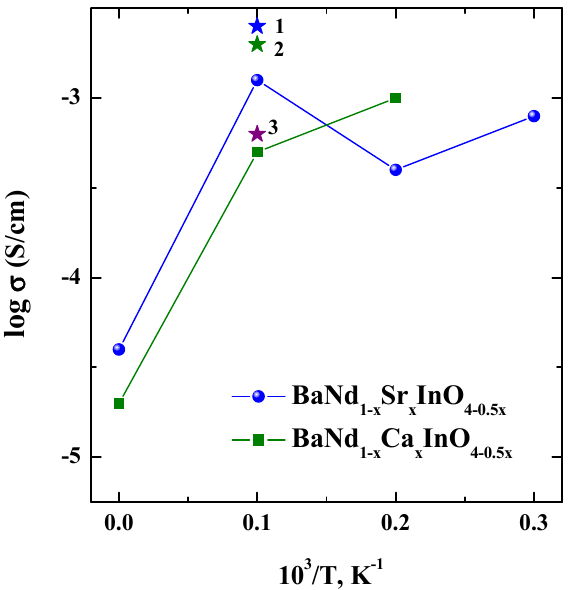
Figure 9. The concentration dependencies of electrical conductivities for the solid solutions BaNd 1 − x Sr x InO 4 − 0.5 x (green) [68] and BaNd 1 − x Ca x InO 4 − 0.5 x (blue) [82], and for the compositions BaNd 0.9 Ca 0.1 InO 3.95 (1) [72], BaNd 0.9 Sr 0.1 InO 3.95 (2) [72], BaNd 0.9 Ba 0.1 InO 3.95 (3) [72] at 600 °C.